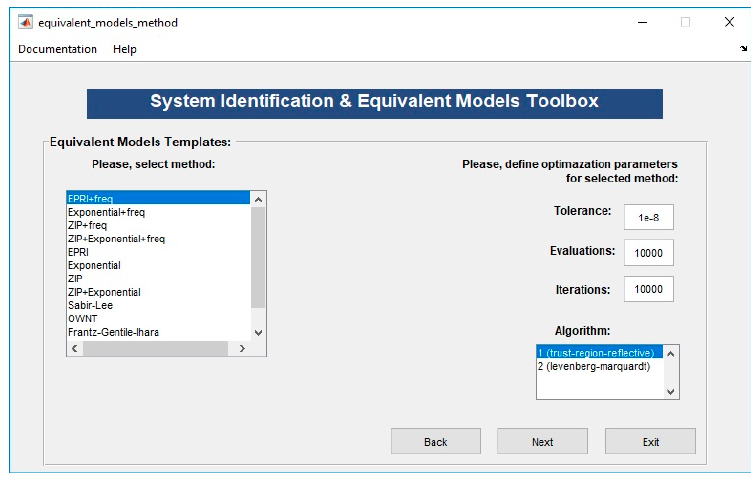
Figure 7. Equivalent method selection window.